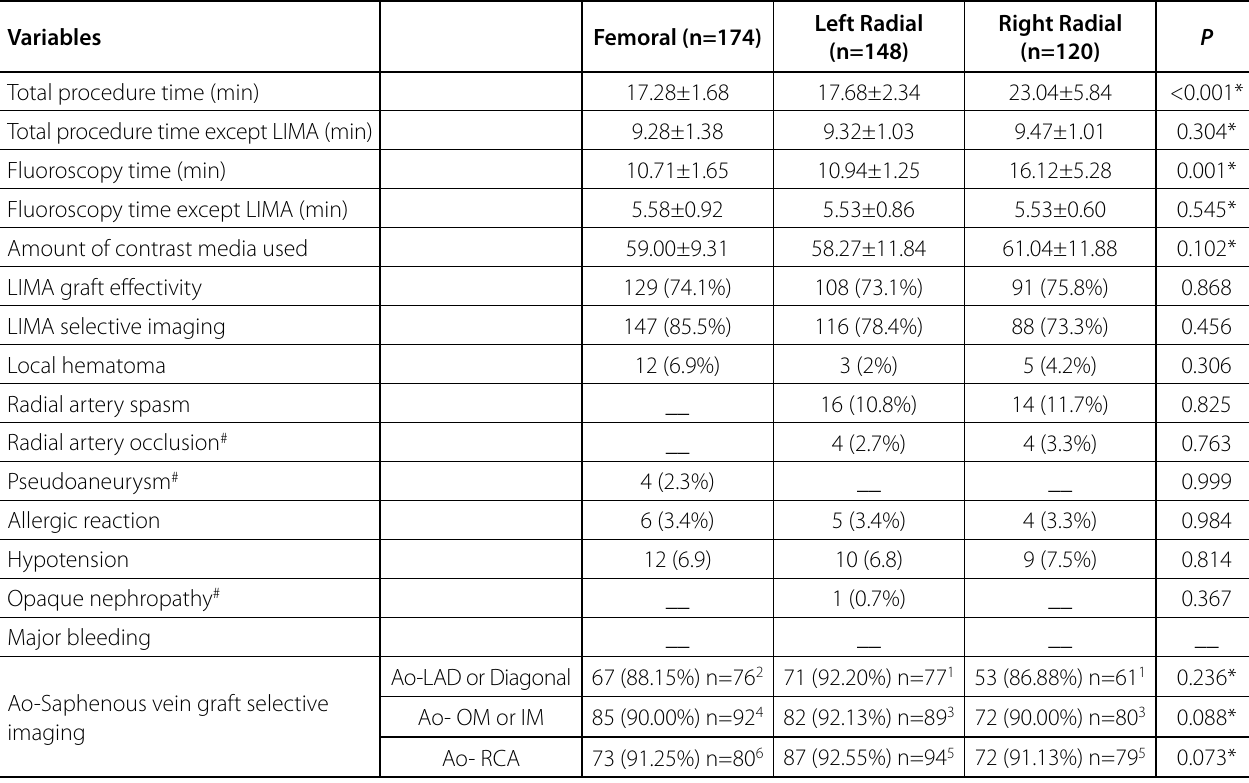
Table 2 . Catheter based results. Femoral vs . left radial group and left radial vs . right radial group.